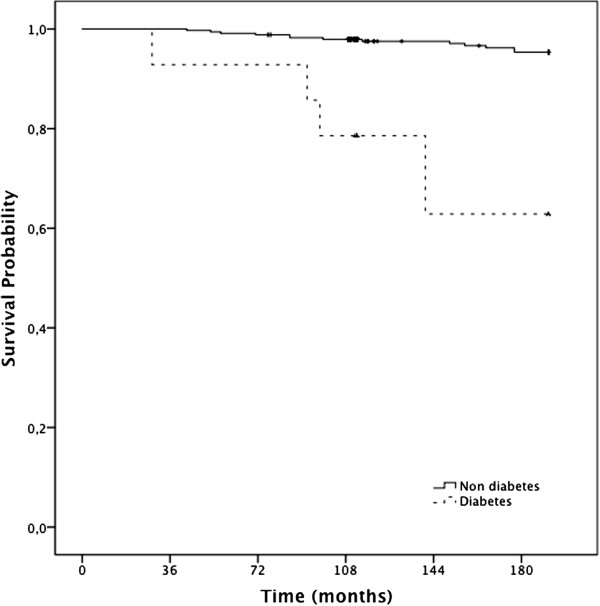
Kaplan Meier estimates of survival among women, according to diabetes prevalence (n=358).